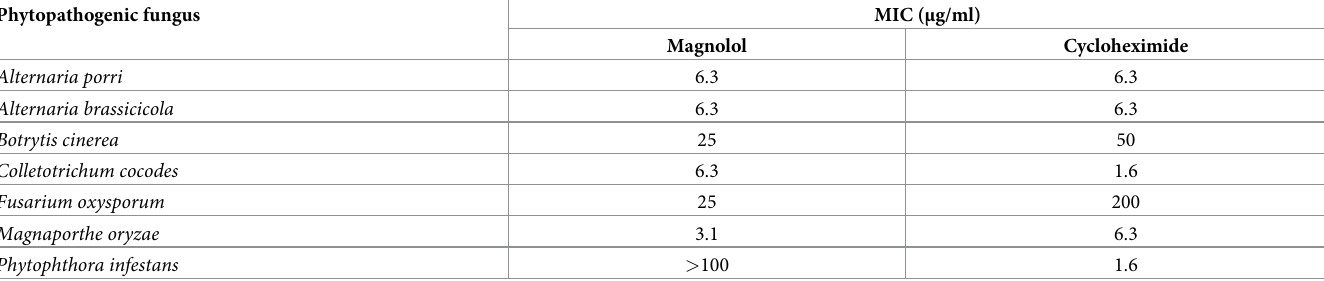
Table 2. Minimum inhibitory concentrations (MICs) of magnolol against phytopathogenic fungi.